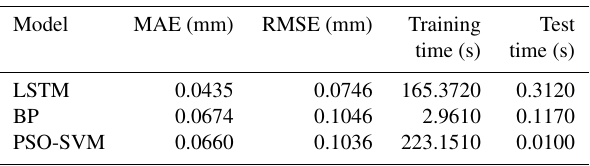
Table 2. Comparison of the prediction effect of LSTM and tradi- tional